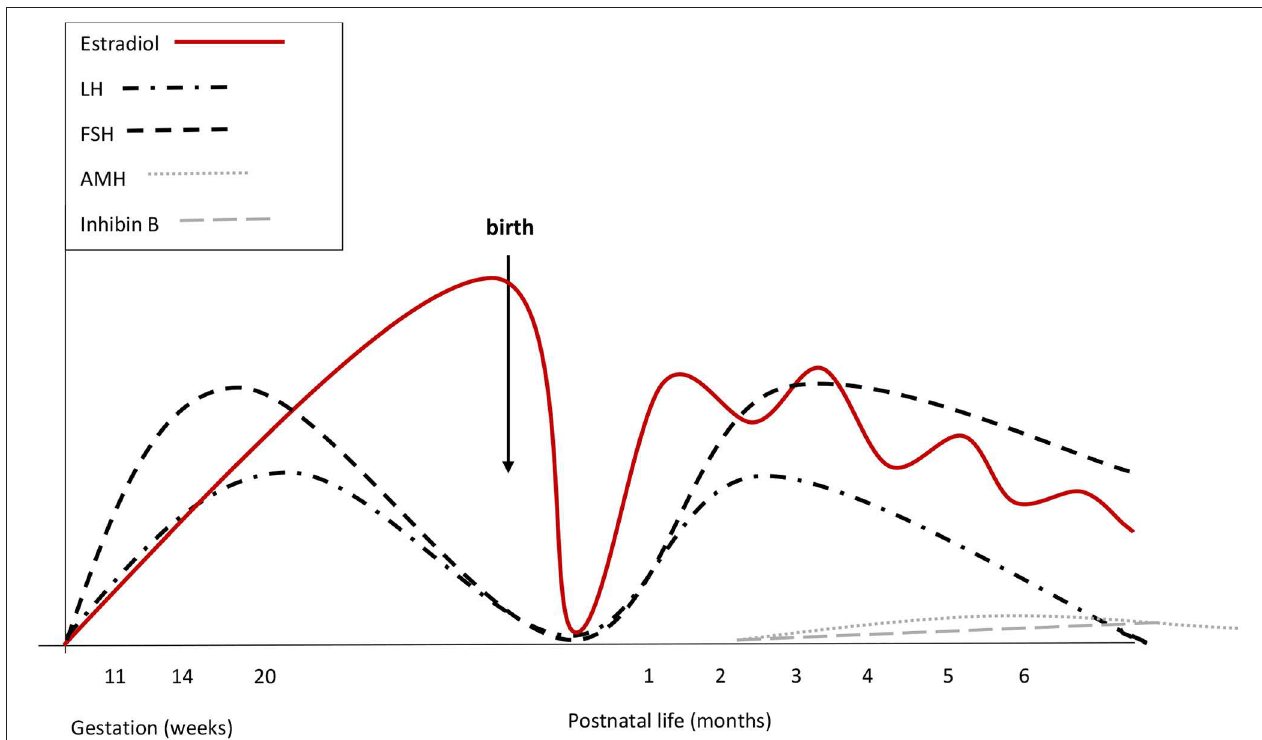
FIGURE 2 | Summary of reproductive hormone changes during early life in healthy girls. Fetal gonadotrophins peak at mid-gestation. Overall gonadotropin levels are higher than in males. During fetal life placental and fetal estrogens overlap. Cord blood LH and FSH are low or undetectable, due to the inhibitory feed-back induced by placental estrogens. There are no peaks of LH or estrogens immediately after birth. Starting from the 2nd week, gonadotropins increase and stimulate estradiol secretion that remains high (although fluctuating) until at least the 6th month. LH declines at the same time as in boys, while FSH remains stably high up to 3 or 4 years of age. Both at mid-gestation and during minipuberty, FSH predominates over